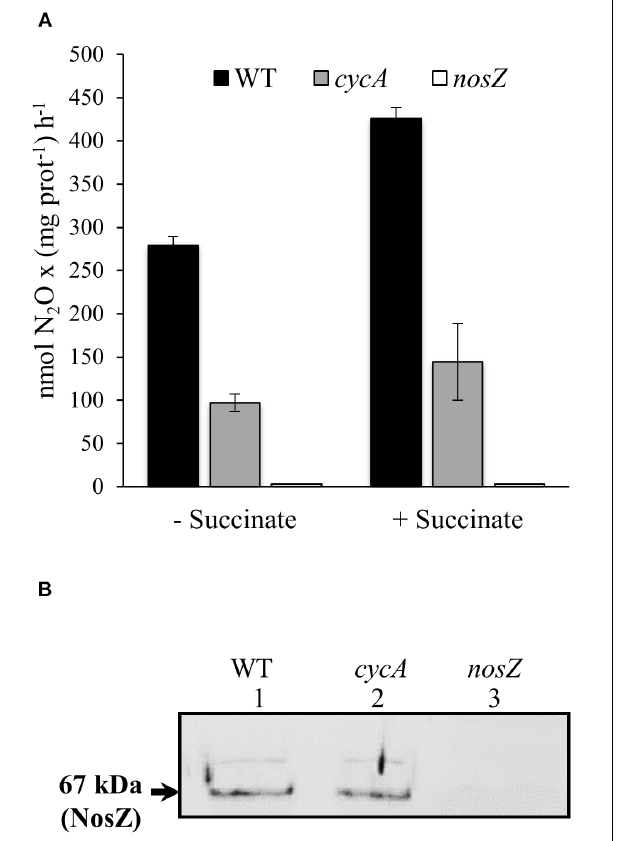
FIGURE 5 | CycA is involved in nitrous oxide reductase activity. (A) N 2 OR activity determined in the WT and cycA mutant in the absence or in the presence of succinate as physiological electron donor. Activity is expressed as nmol N 2 O consumed per (mg prot) - 1 h - 1 . Shown are means with standard errors of the three measurements of one representative experiment from at least two independent biological replicates. (B) Immunodetection of NosZ protein in the soluble fraction of the WT and cycA mutant. 20 µ g of the soluble fraction of each strain were resolved by SDS-PAGE and immunoblotted with anti-NosZ antibody from P. denitrificans (for a detailed description see section Materials and Methods). The size of the predicted molecular mass of the mature periplasmic NosZ protein (67 kDa) is indicated on the left side. The original image of the immunoblot is shown in Supplementary Data Sheet S2B . In both series of experiments (A,B) , cells were grown microoxically (2% O 2 ) for 24 h in YEM medium supplemented with nitrate. A nosZ mutant was included as negative